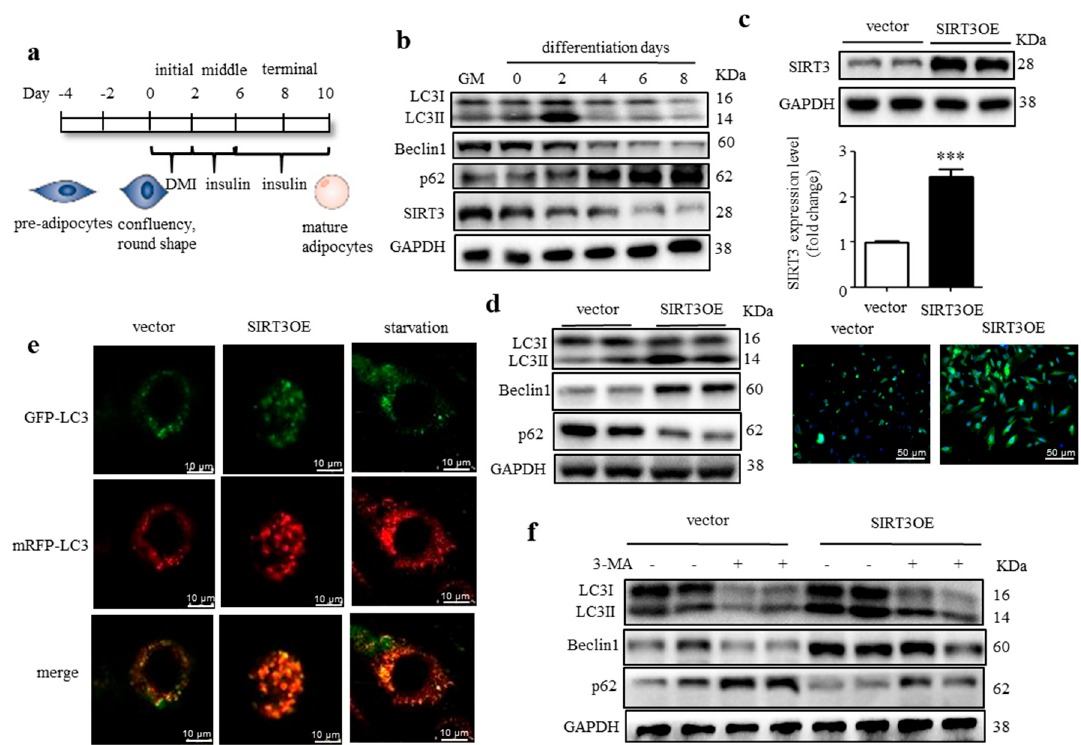
Figure 1. Macroautophagy is dynamically regulated during adipocyte differentiation and SIRT3 positively regulates macroautophagy in adipocytes. ( a ) The procedure of 3T3-L1 adipocyte differentiation; ( b ) Expression of SIRT3 and macroautophagy related proteins during adipocyte differentiation were analyzed by Western blots; ( c ) Generation of SIRT3 overexpressed 3T3-L1 cell line. SIRT3 protein level was detected by western blots and immunofluorescence (green), scale bar = 50 µ m. ( d ) Expression of macroautophagy-related proteins in SIRT3OE and vector cells was analyzed by Western blots. GAPDH was used as a loading control; ( e ) SIRT3OE and vector 3T3-L1 cells were transiently infected with the mRFP-GFP-LC3 lentivirus. mRFP-GFP-LC3 puncta were examined using a confocal microscope. Scale bar = 10 µ m. ( f ) SIRT3OE and vector cells were treated with 3-MA for 24 h. Expression of macroautophagy related proteins was analyzed by Western blots. GAPDH was used as a loading control. Data represented means ± S.D., n = 6, *** p < 0.001 SIRT3OE versus vector cells.